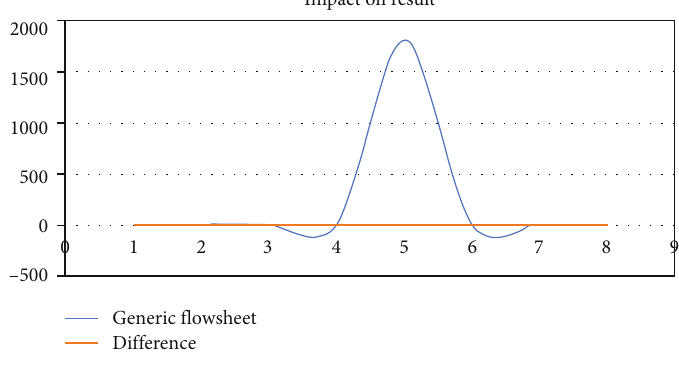
Figure 7: Impact on